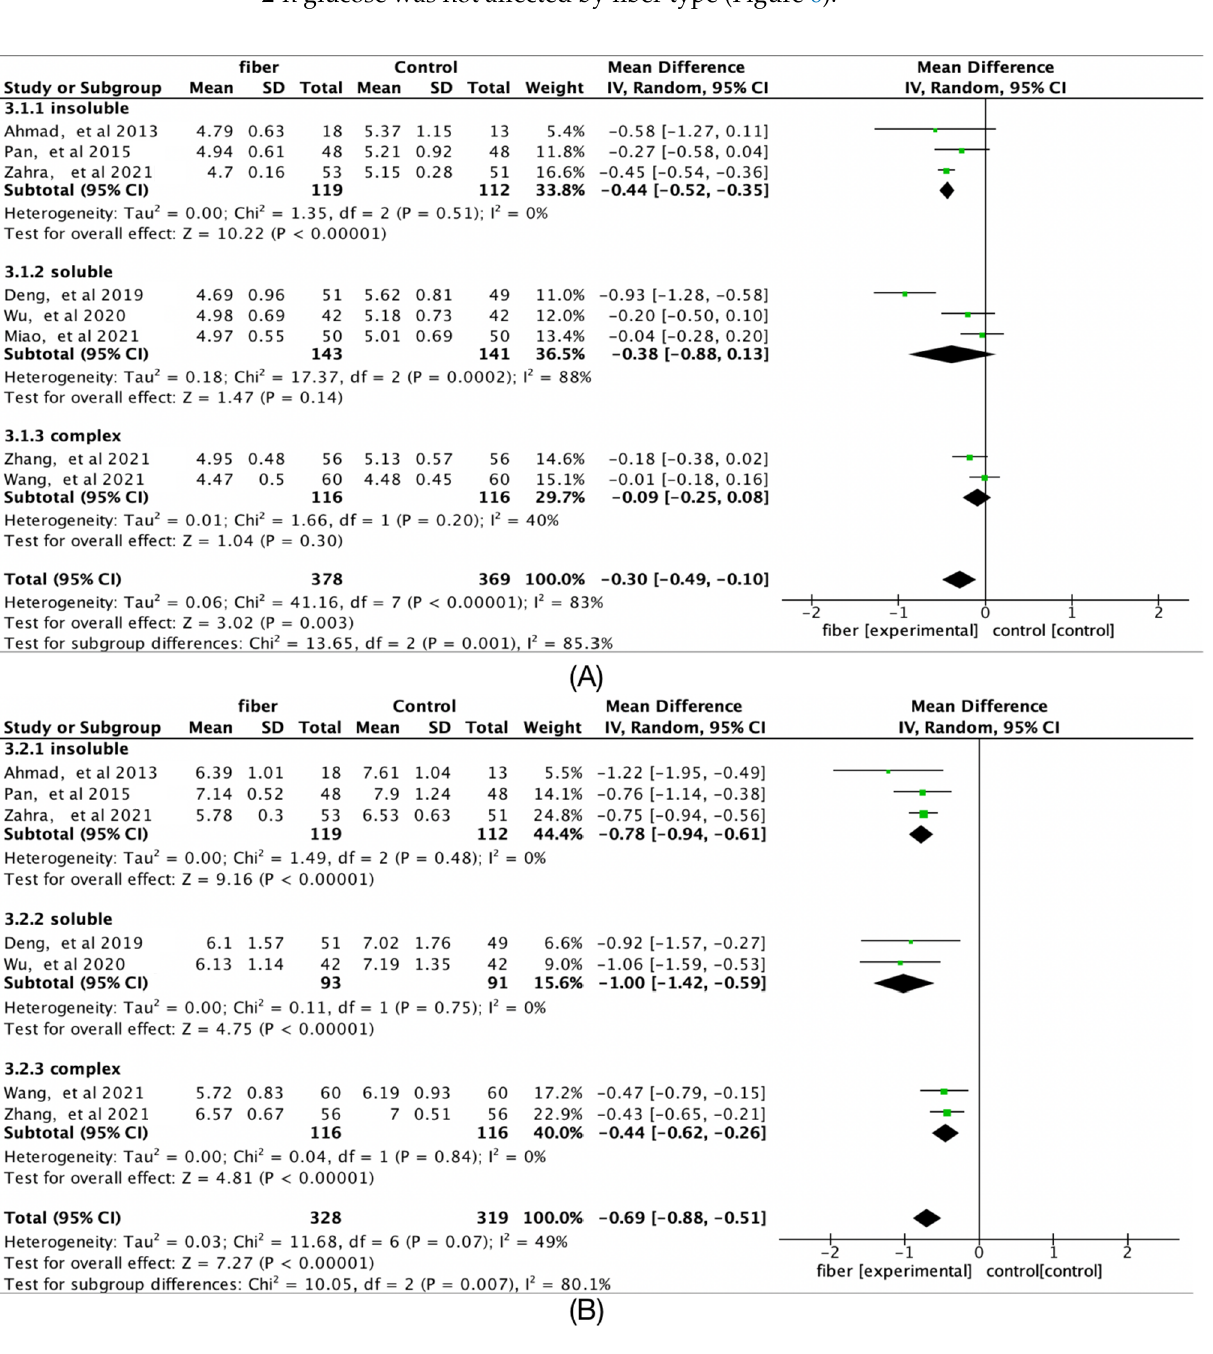
Figure 6. Forest plots of subgroup analysis of fiber type on ( A ) fasting glucose (mmol/L) and ( B ) 2-h glucose (mmol/L).[14–21]